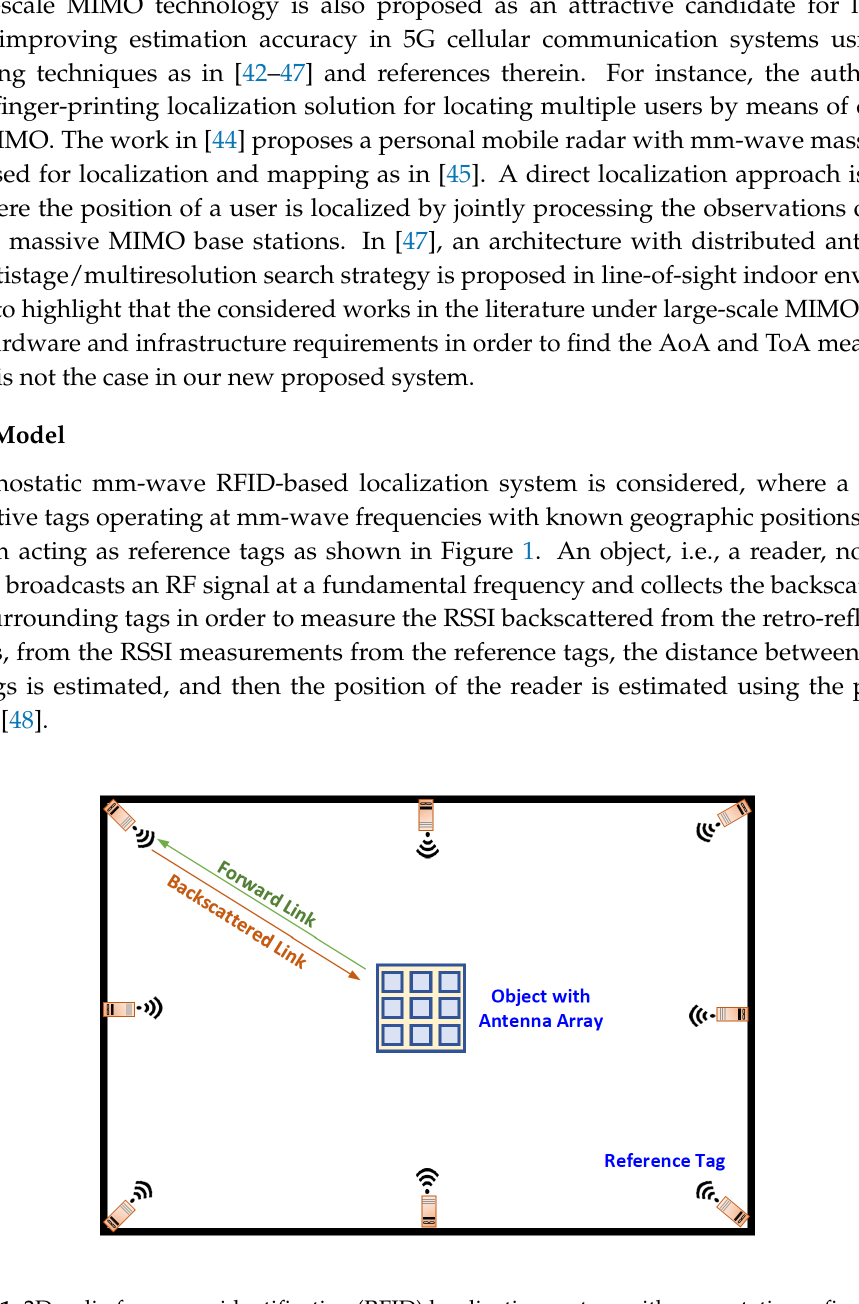
Figure 1. 2D radio frequency identification (RFID) localization system with monostatic